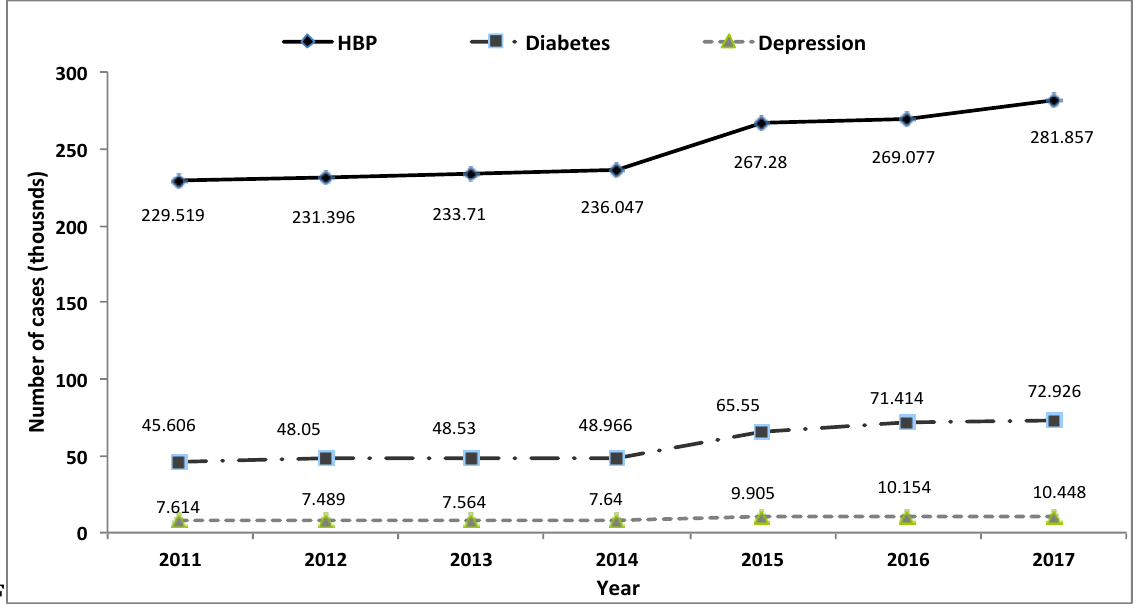
Figure 1. Number of cases of hypertension, diabetes and depression in NCD registries of PHC centres, from